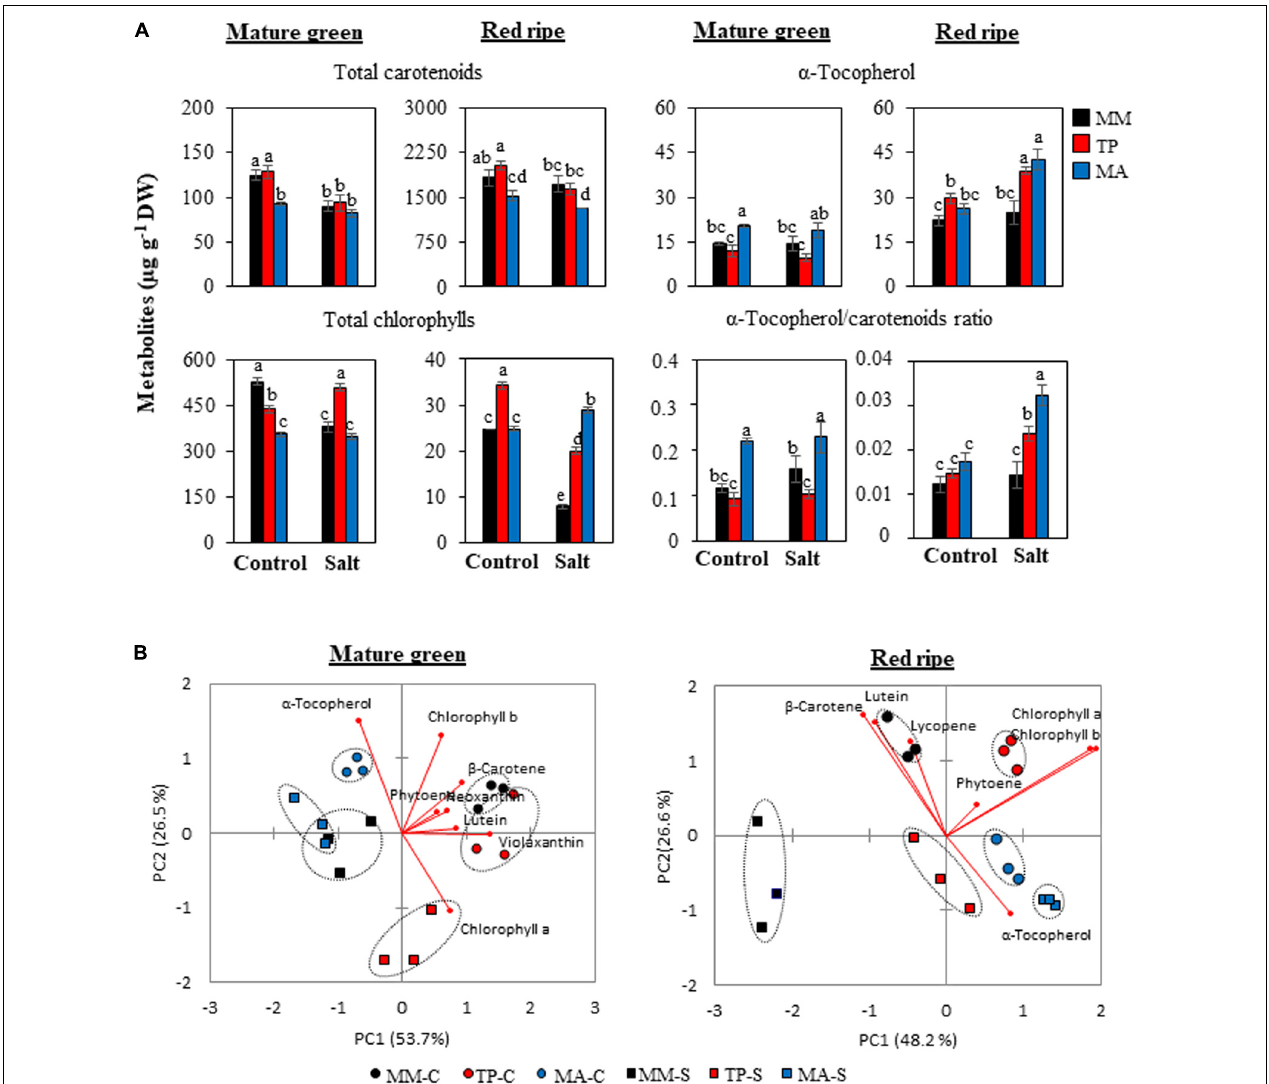
FIGURE 6 | Secondary metabolites in mature green and red ripe fruits of “Moneymaker” (MM) and two traditional varieties, “Tomate Pimiento” (TP) and “Muchamiel Aperado” (MA), from plants grown in control (C) and salt (50 mM NaCl) (S). (A) Accumulation of total carotenoids, total chlorophylls, and α -tocopherol, and α -tocopherol/carotenoid ratio. Three biological replicates of 10 fruits each were used. Values are expressed as means ± SE. Different letters indicate statistically significant differences according to Tukey’s test ( p < 0.05). (B) Graphical representation of principal component analysis representing the major sources of variability for secondary metabolites in mature green and red ripe